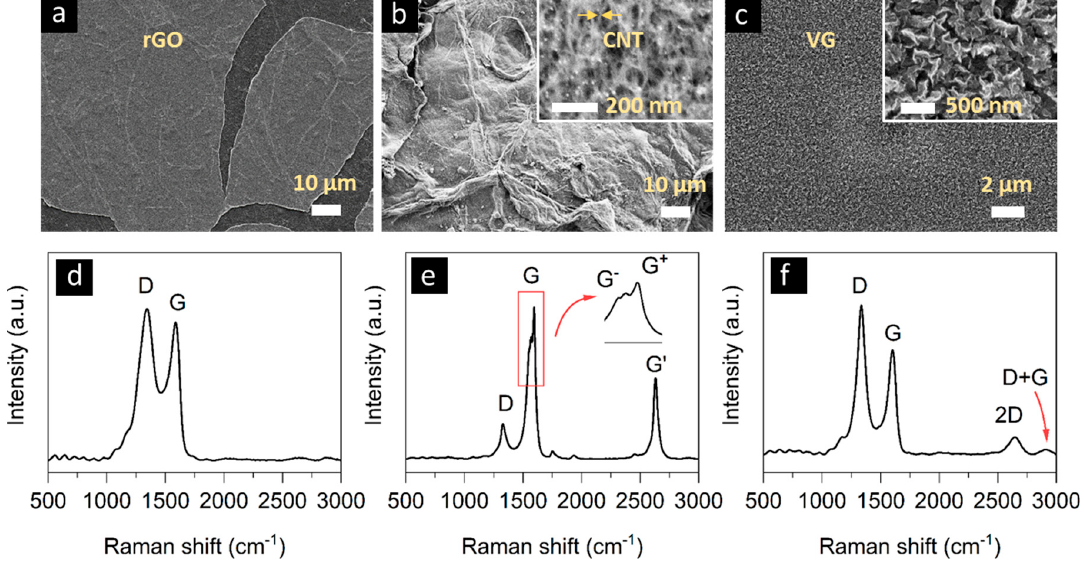
Figure 3. SEM images of ( a ) rGO, ( b ) carbon nanotubes (CNT), and ( c ) a vertical graphene (VG) layer as electrode materials on an SiO 2 surface. Insets show higher magnification of the respective sample. Raman spectroscopy images of each material are shown in ( d ), ( e ), and ( f ), respectively.